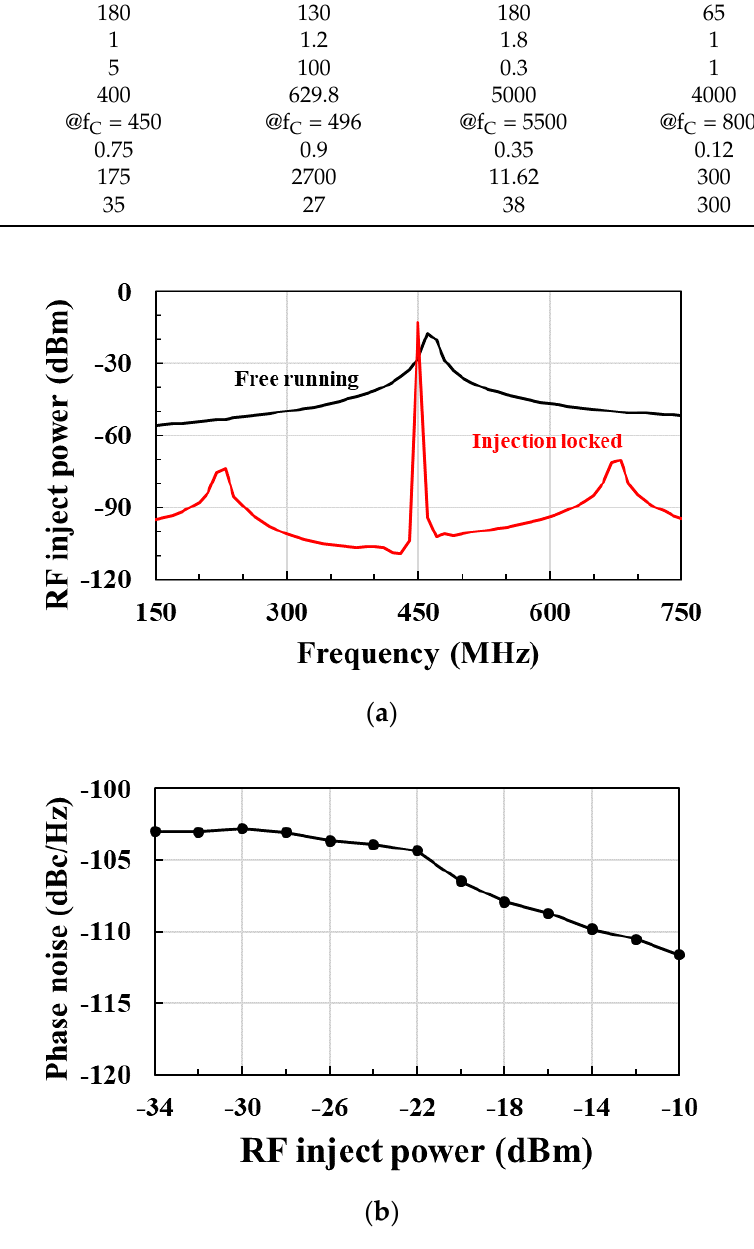
Figure 13. ( a ) Power spectral density (PSD) of the injection-locked RF clock harvester with and without RF injection power of − 15 dBm; ( b ) phase noise of the RF clock harvester at 1 MHz offset according to the RF injection power.